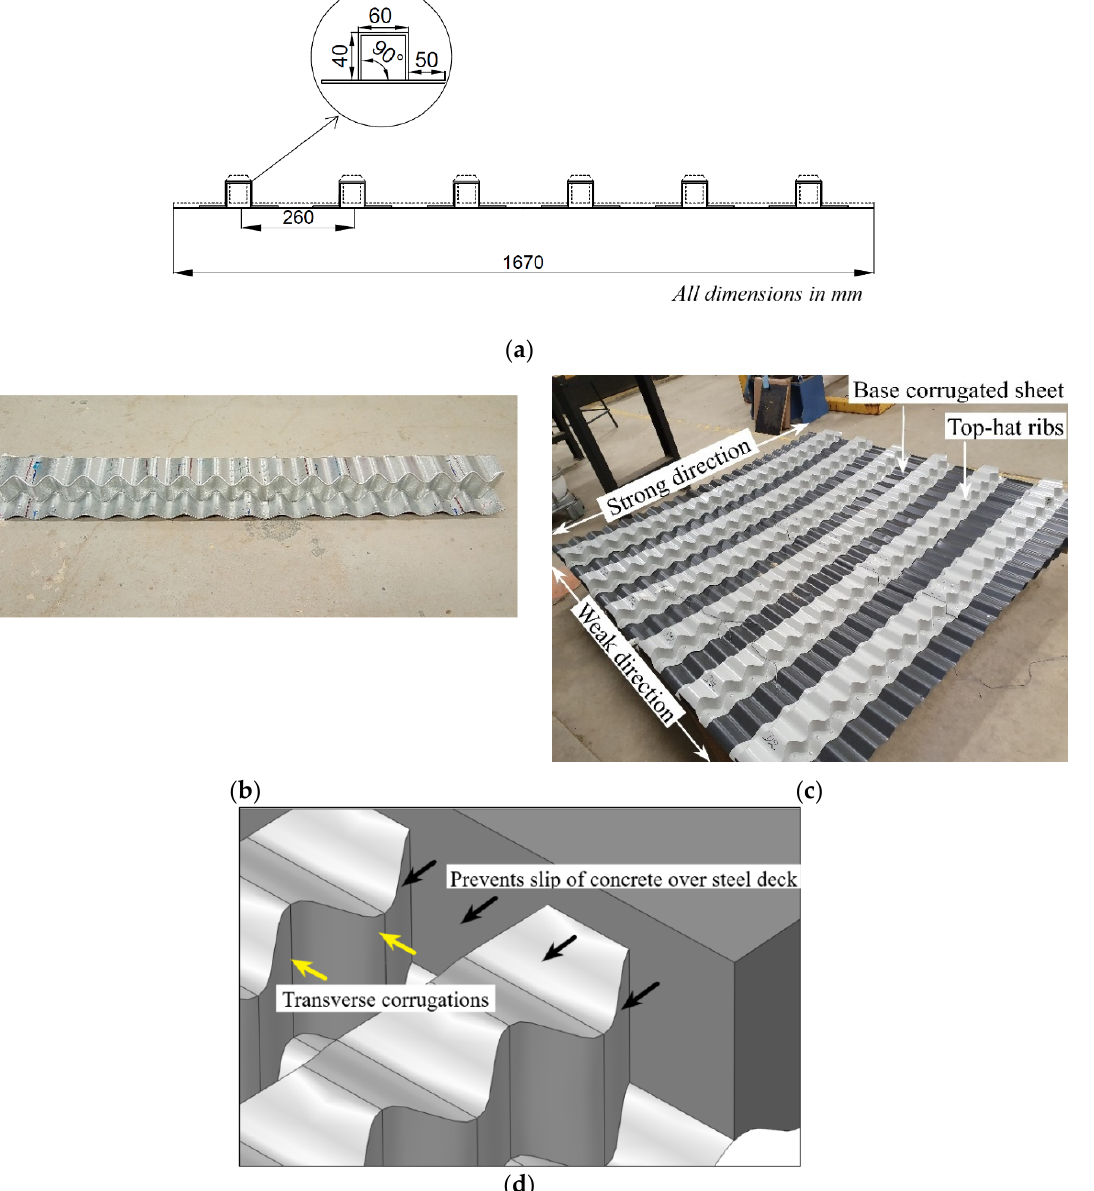
Figure 1. Two-way steel deck system. ( a ) Cross-section dimensions of two-way deck system. ( b ) Corrugated top-hat rib section. ( c ) Assembled two-way deck. ( d ) Mechanism of shear bond in new deck profile.